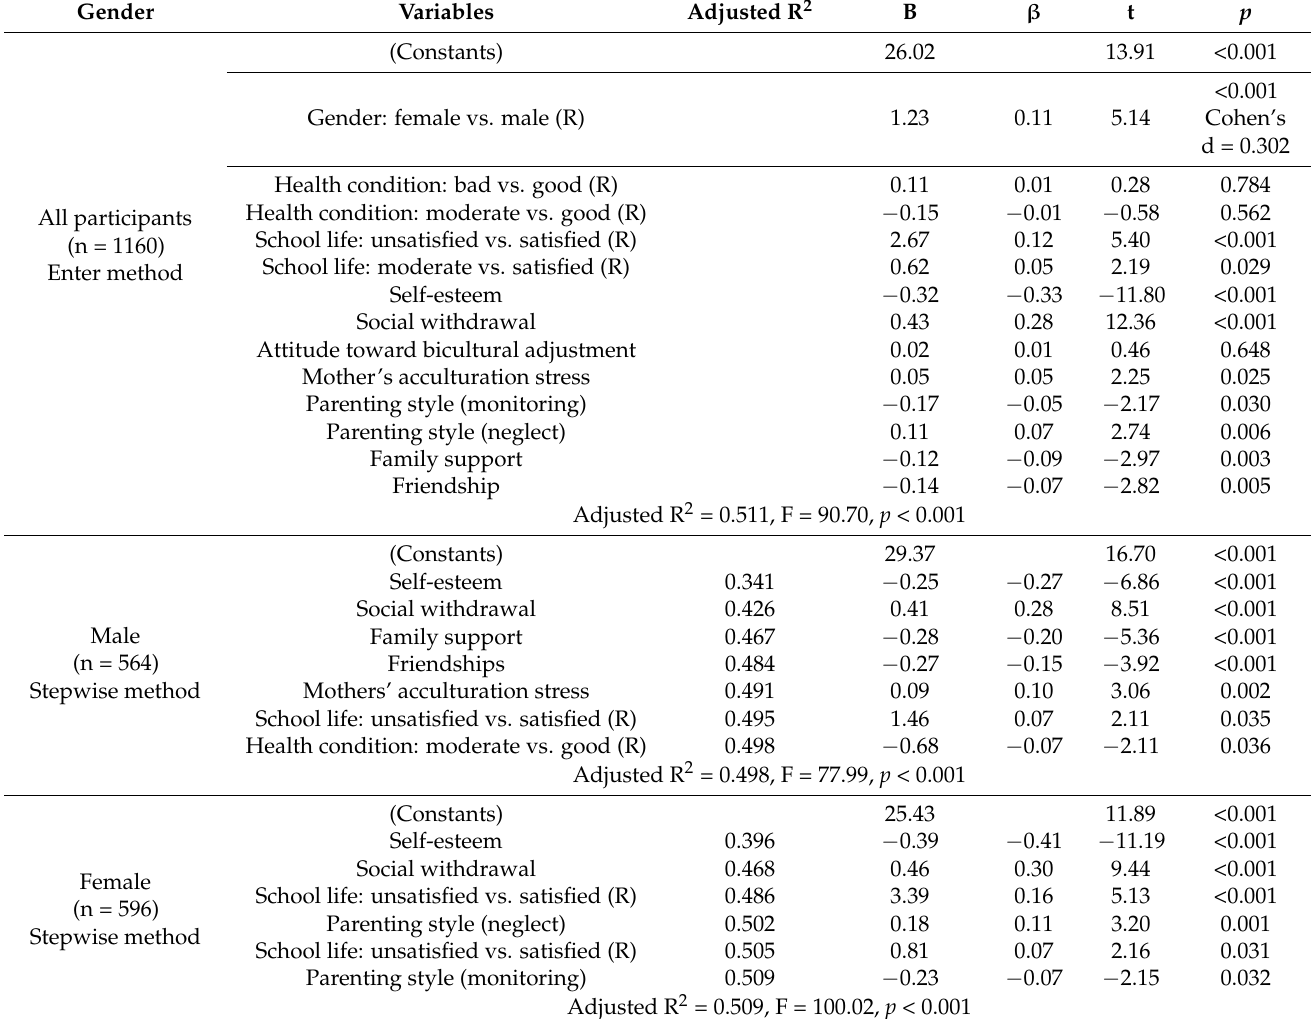
Table 4. Factors influencing multicultural adolescents’ depression by gender (n =